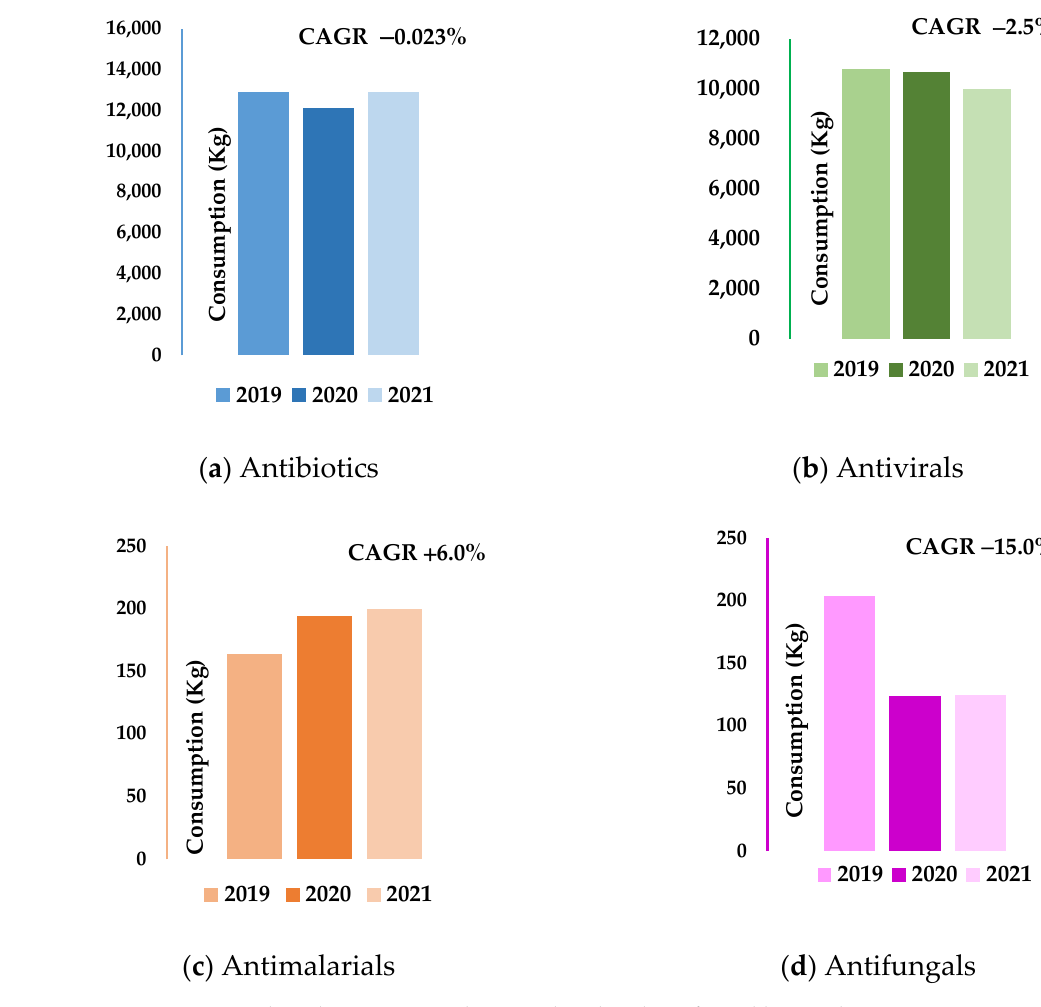
Figure 1. Annual antibiotic, antiviral, antimalarial and antifungal hospital consumption rates (kg). ( a ) Antibiotics—hospital; ( b ) Antivirals—hospital; ( c ) Antimalarials—hospital; ( d ) Antifungals— hospital. CAGR—Compound Annual Growth Rate.